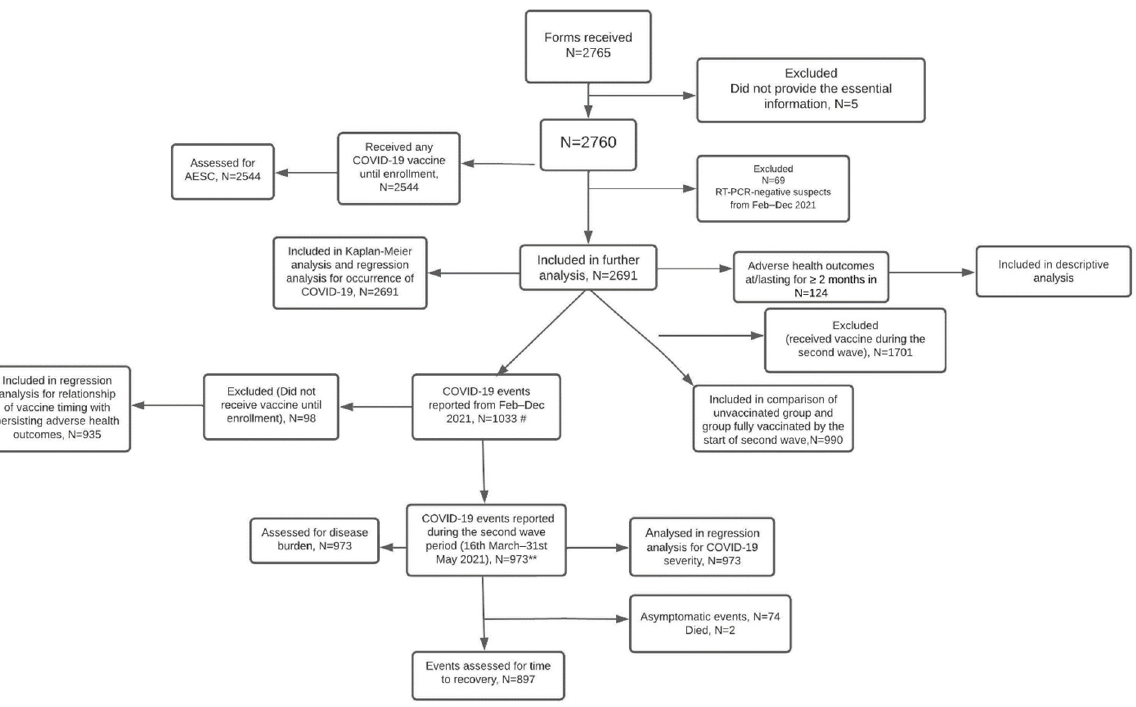
Figure 1. STROBE Flow diagram of selection of participants and steps followed for each analysis. # 1033 COVID-19 events occurred in 1027 participants ** 973 COVID-19 events occurred in 969 participants